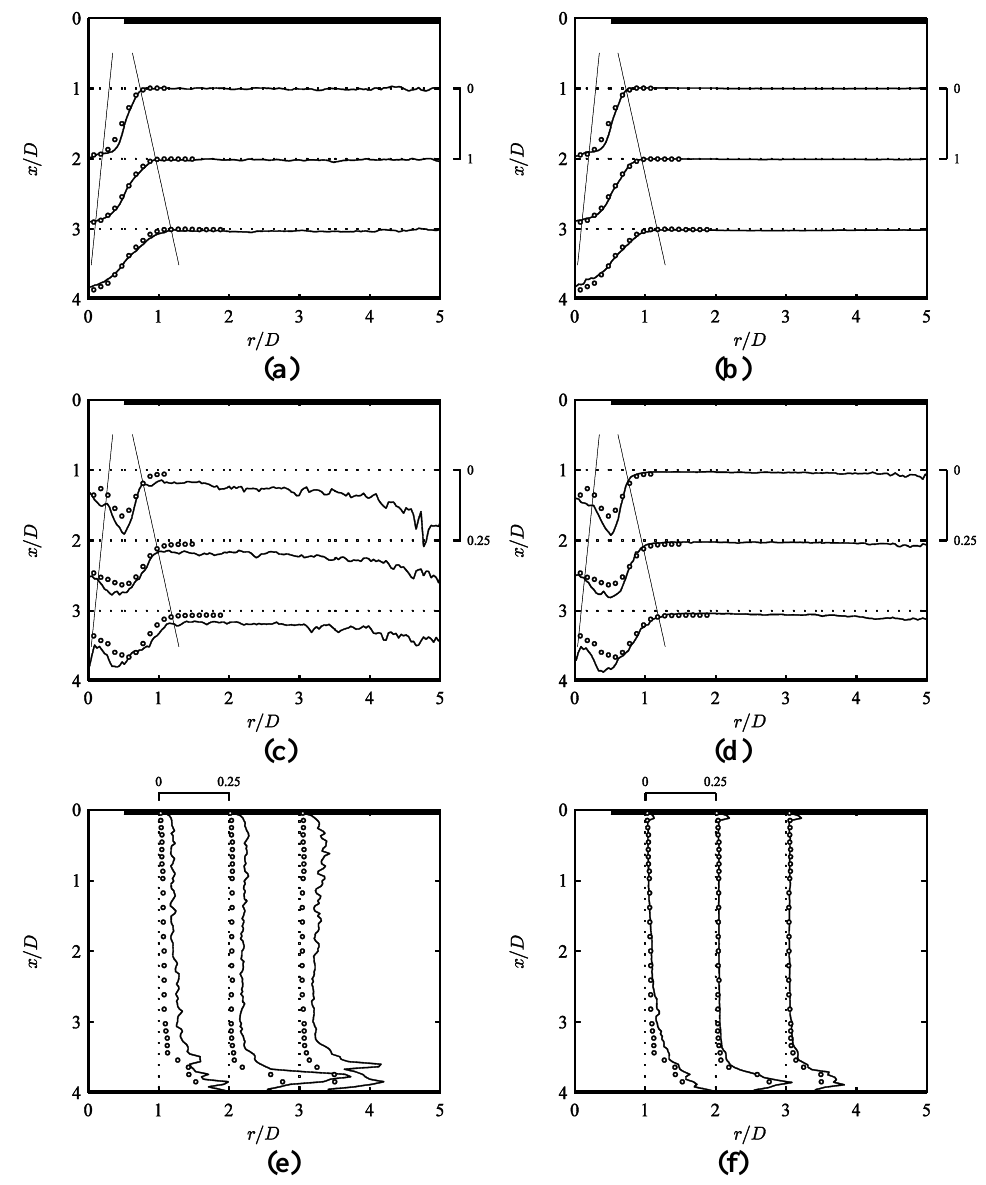
Figure 6. Comparison of (a,c,e) conventional PIV and (b,d,f) MPS PIV (  p = 5 in Equation (8)) against LDV measurements (circular markers): profiles of (a,b) time-averaged axial velocity U ( r )/ U (e,f) radial turbulence intensity v’ ( x )/ U